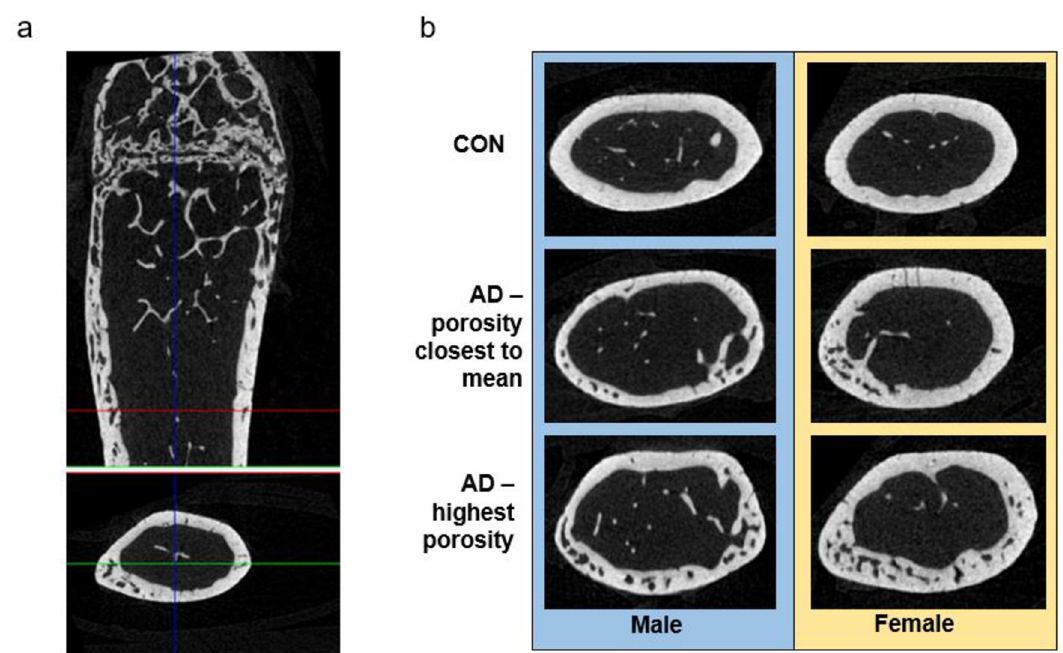
Fig 4. Representative images of cortical bone. A) Representative image from a female adenine mouse of the distal 1/3 region of the femur used for cortical porosity analysis. B) Representative images of cortical sections of controls (closest to mean of porosity), adenine (closest to mean of porosity), and adenine mice with the highest porosity.